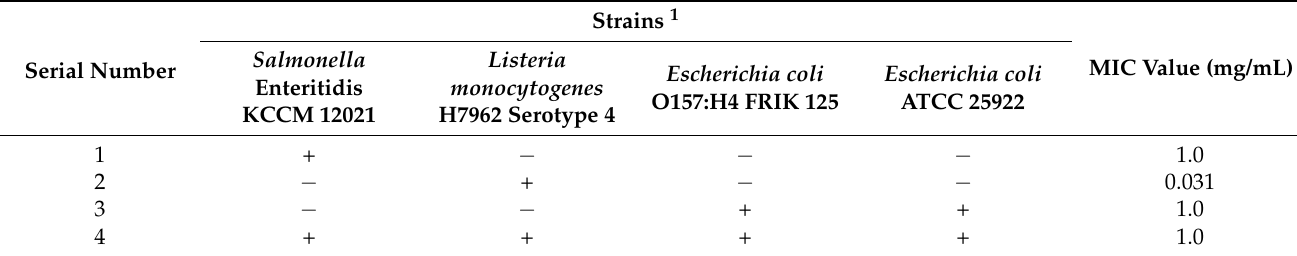
Table 1. Minimum inhibitory concentration (MIC) values obtained by ε -PL against mono-species cultured strains and multi-species cultured strains.